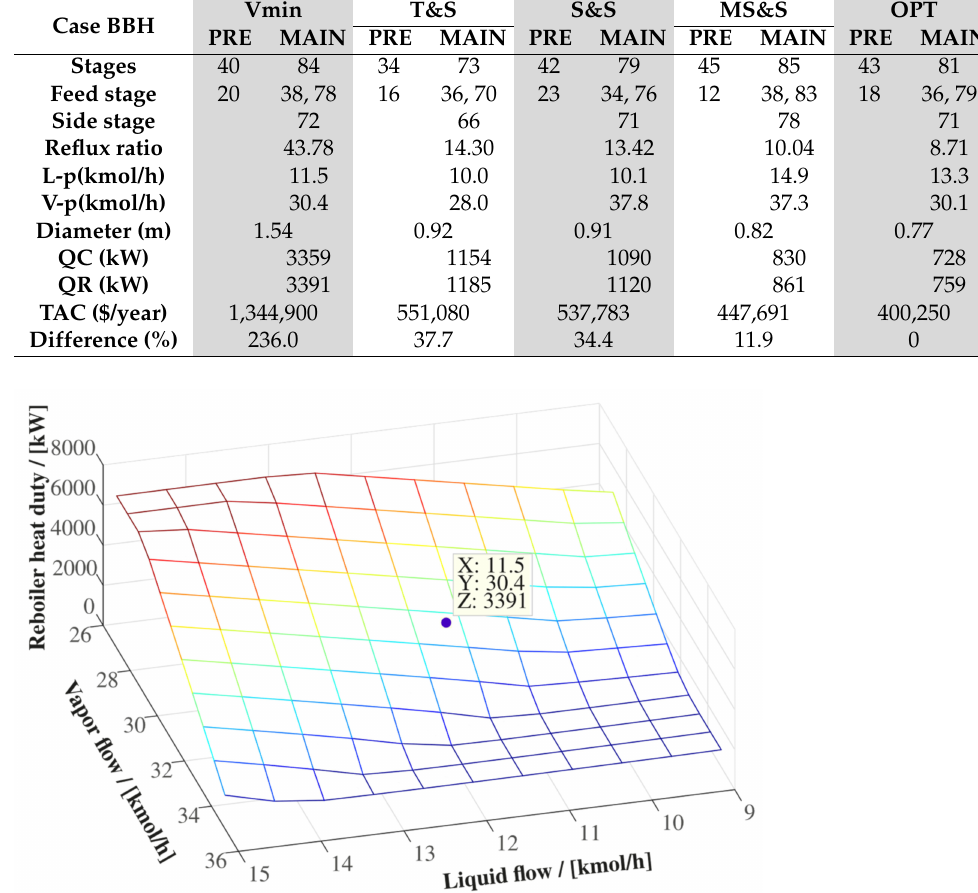
Figure 8. Sensitivity analysis for the DWC design obtained with the Vmin method for the BBH mixture.